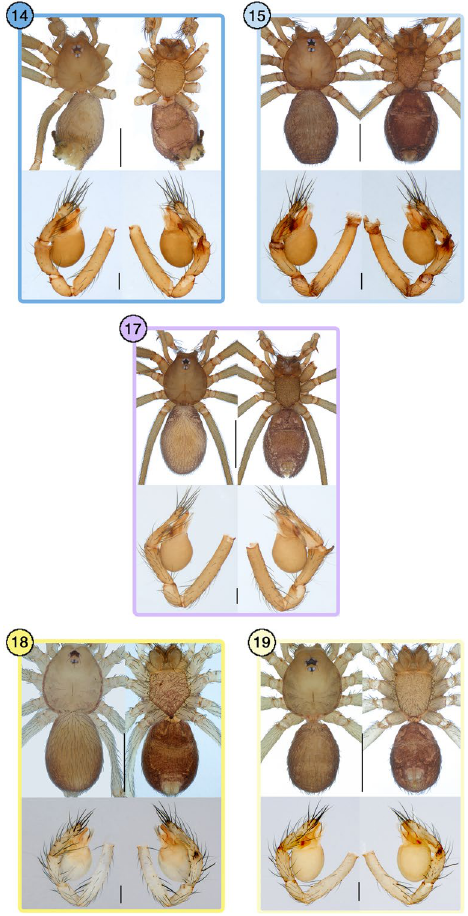
Figure 7. Morphological photographs of each cryptic species from Fig. 6. upper panels: habitus (dorsal and ventral view); lower panels: left palp (prolateral and retrolateral view). The numbers of each panel match the numbers from Fig. 6. Scale bars: upper panels = 0.5 mm, lower panels = 0.1